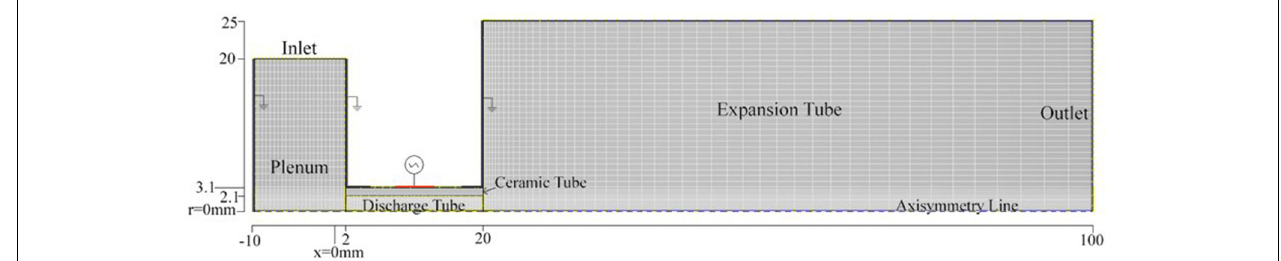
FIGURE 2 | Pocket Rocket model dimensions and mesh distribution used for CFD simulations.